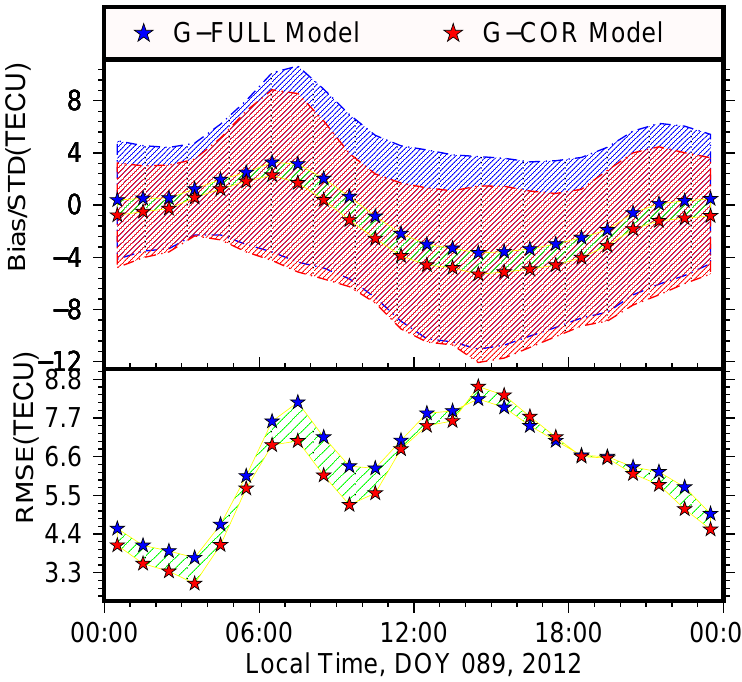
Figure 15. Hypothesized model error: G-FULL Model refers to the deviation, standard deviation and error rms variation between the results obtained by bottom assimilation using the ground data affected by the top region and the GIM model of the IGS. G-COR Model refers to the result of a correction strategy that deducts the influence of the top